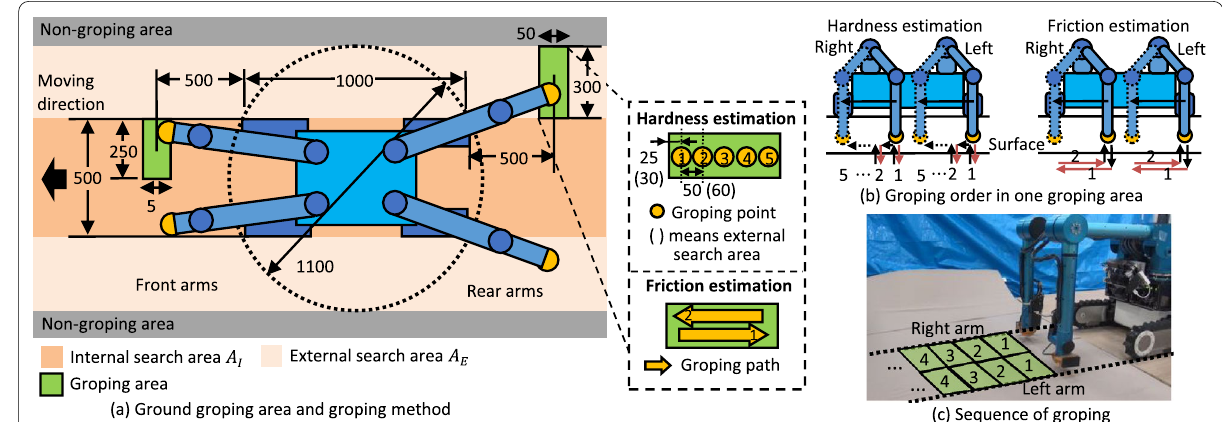
Fig. 4 Design of ground groping mode (GGM). Groping order of right and left arm are the